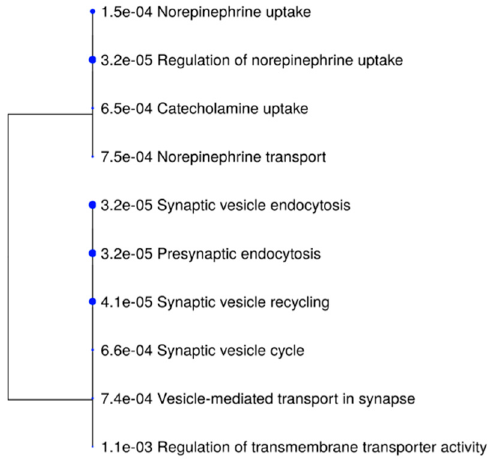
Figure 5. Hierarchical clustering tree summarizing the top 10 most significantly enriched GO terms that were identified in rat forebrain cortex. The analyzed dataset was consisted of 6 significantly differentially expressed cortical proteins. Table 4. GO enrichment analysis for significantly upregulated and downregulated proteins identified in the rat forebrain cortex isolated from animals after 6 months of morphine withdrawal; carried out using the ShinyGO v0.74 tool (bioinformatics.sdstate.edu/go). The top ten most significantly enriched GO terms for biological processes are